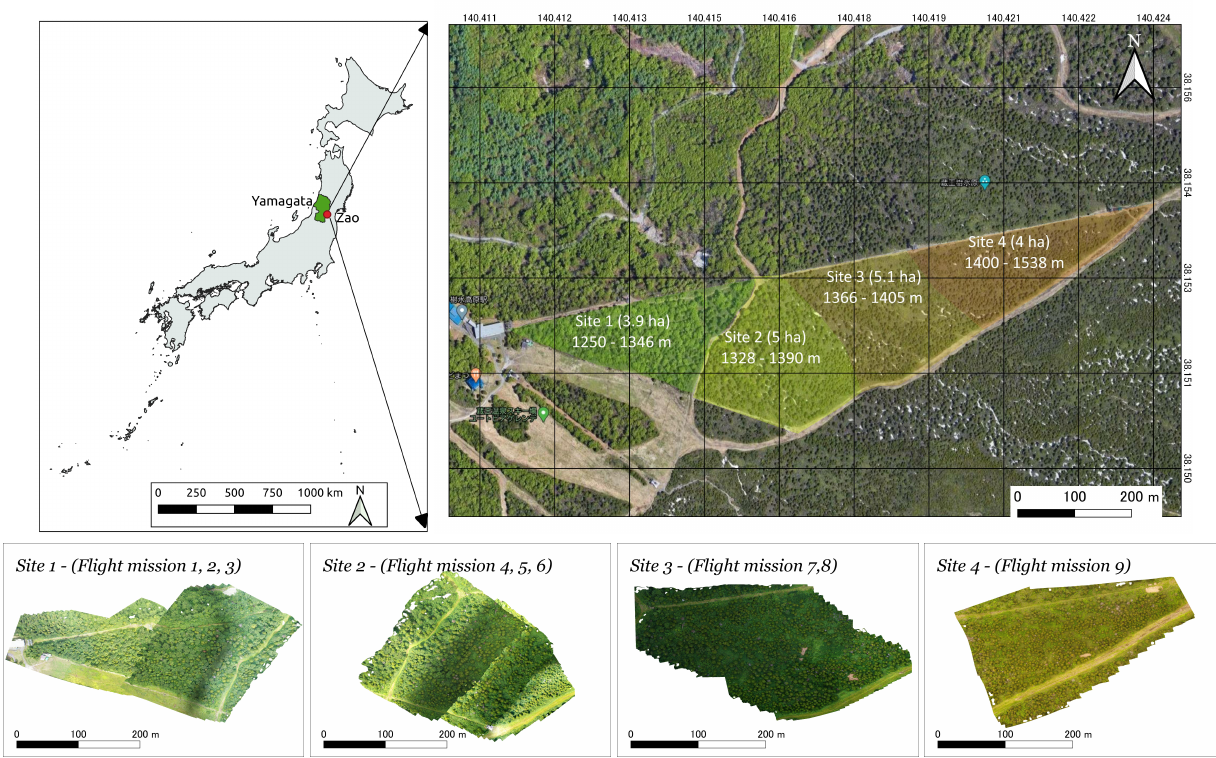
Figure 1. The four study sites are located in Zao Mountain, Yamagata prefecture, Japan. A gradual increase in elevation from site 1 to site 4 together with the increasing number of fir trees infested by bark beetles, followed by the decrease of mixing rate with deciduous species (background map from Google Hybrid